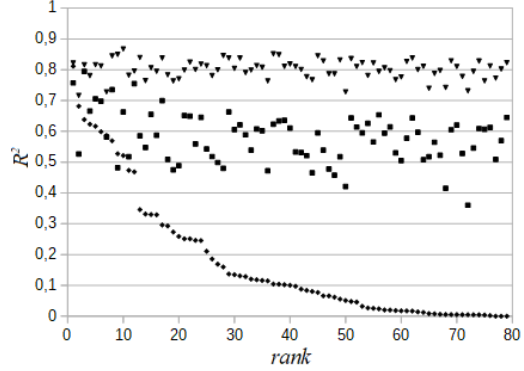
Fig. 2. Result for models of type 6b.